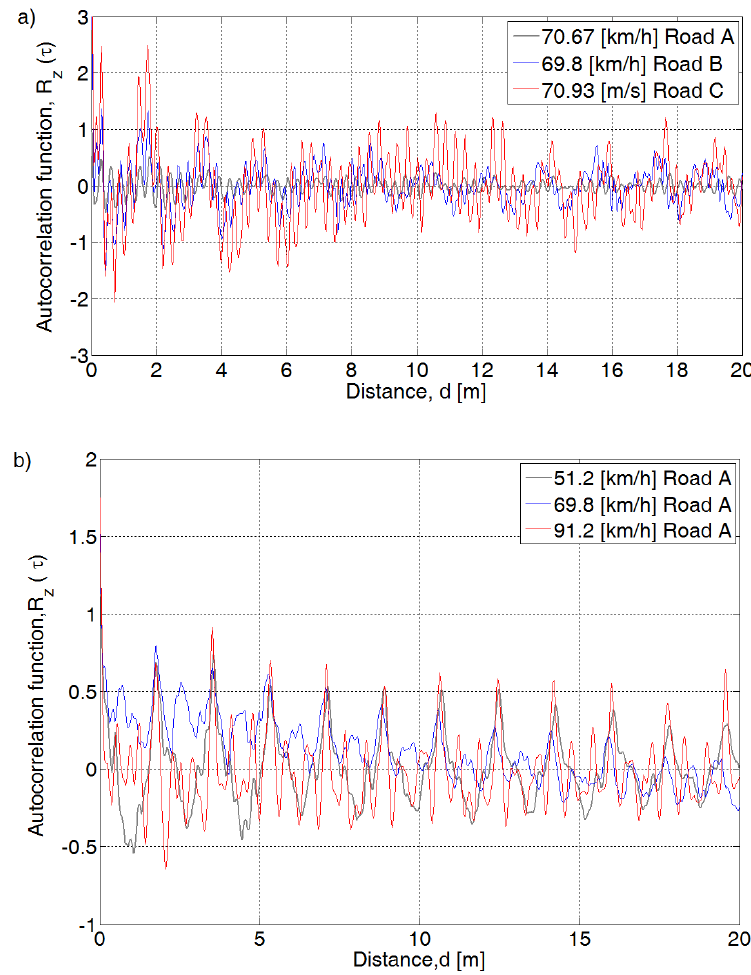
Figure 6. Graphs of the autocorrelation function of the body acceleration signal, for selected vehicle speeds different surfaces A, B, C for constant speed ( a ), and different speed ( b ) for road A.